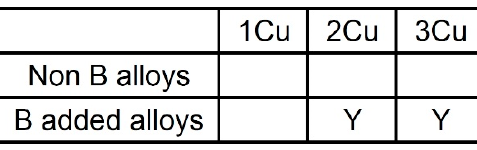
Figure 12. Liquid phase separation (LPS) tendency in the Co-Cr-Cu-Fe-Mn-Ni and Co-Cr-Cu-Fe-Mn-Ni-B HEAs focusing on the existence of B and Cu concentrations.